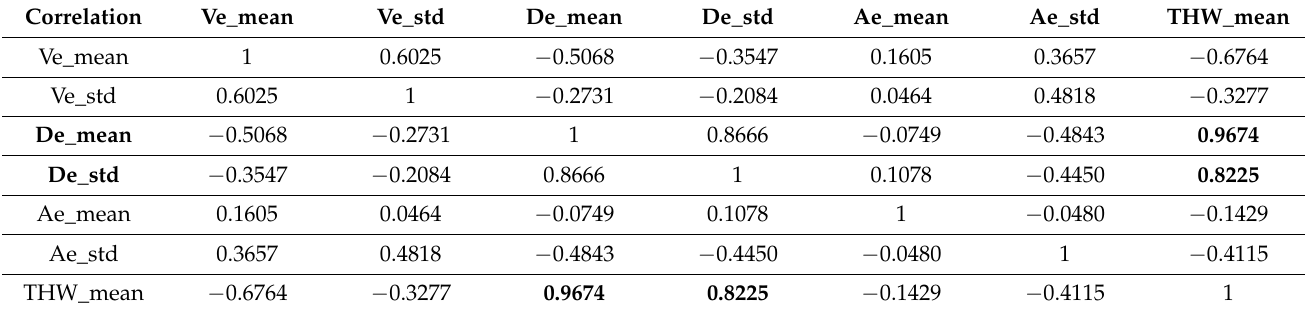
Table 7. Pearson correlation coefficients between the seven traditional statistical